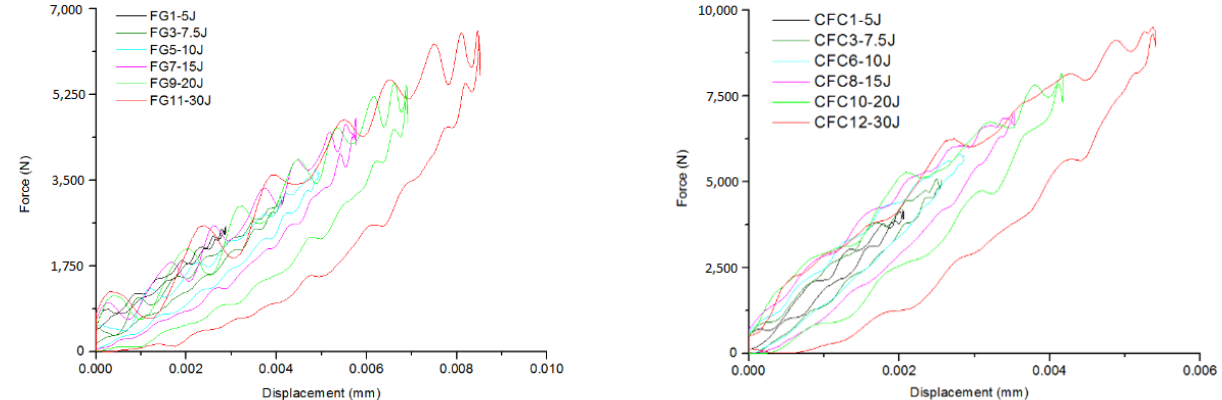
Figure 5. Force displacement curves for carbon fibers ( left ) and glass fibers ( right ).